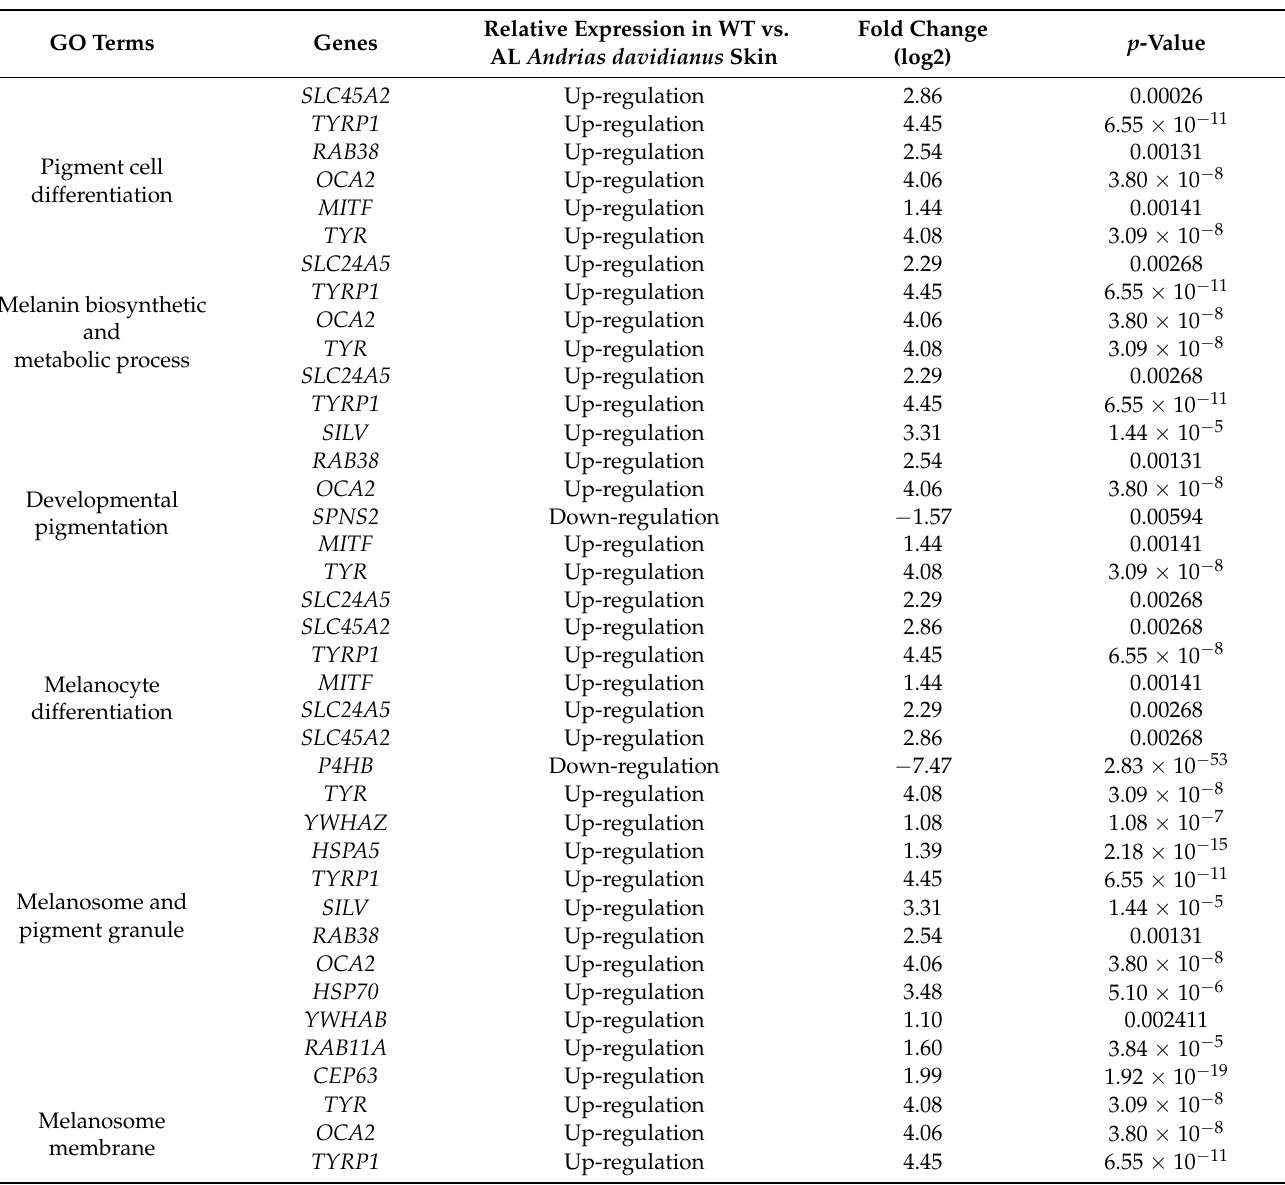
Table 3. DEGs and their GO terms related to pigmentation and melanogenesis in WT versus AL Andrias davidianus